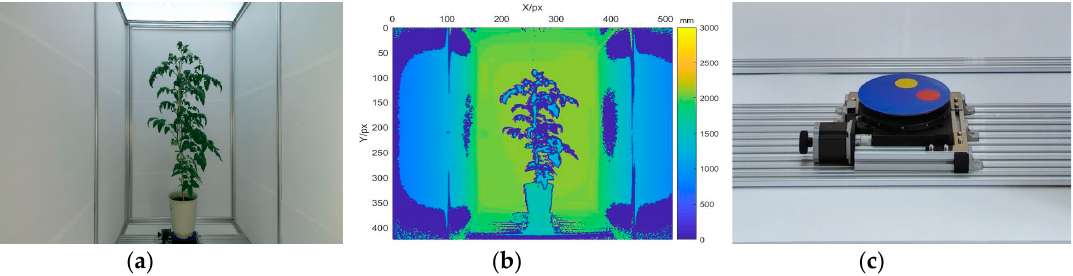
Figure 1. Images captured in the imaging chamber. ( a ) color image of a plant, ( b ) depth image of a plant, ( c ) precision turntable.